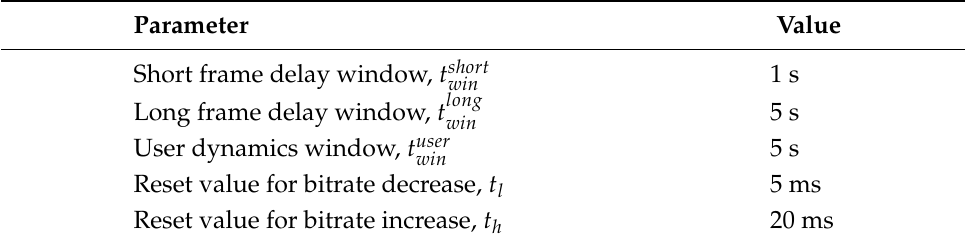
Table 2. Enhanced VR bitrate Estimator (EVeREst) algorithm parameters.